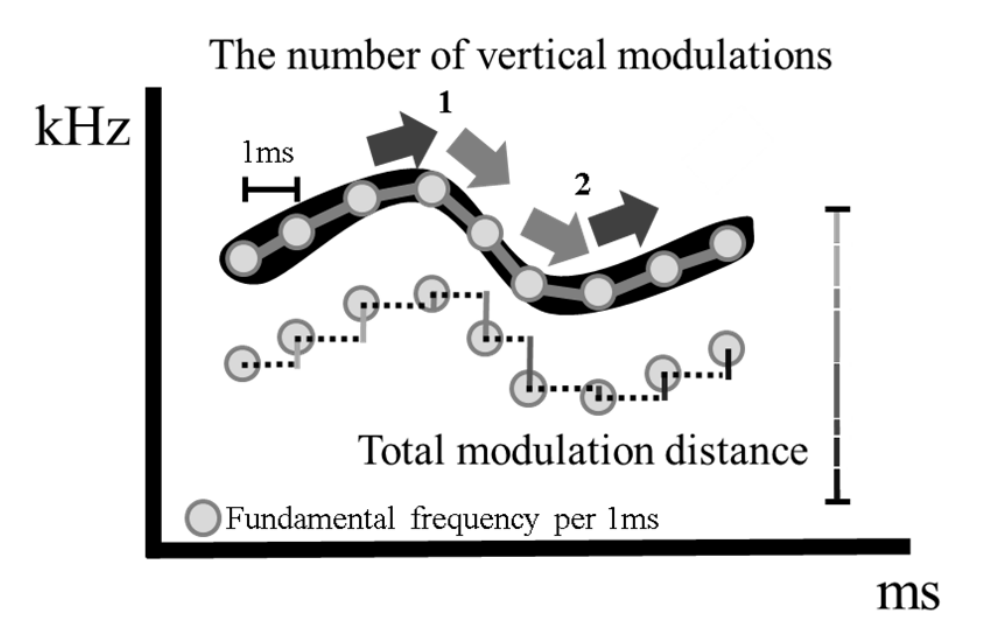
Figure 2 . Two parameters, frequency and time, reflect frequency modulation. The number of vertical modulations (inflections) of the fundamental frequency within the call. For example, if fundamental frequency increased between 1 and 2 ms point, but decreased between 2 and 3 ms point, we regarded that there should be one vertical modulation between 1 and 3 ms. The total modulation distance (in kHz) was considered to be equal to the sum of the absolute difference between adjacent fundamental frequency points per ms. This is equal to the cumulative frequency modulations. The total modulation distance is 0-kHz if there was no modulation in fundamental